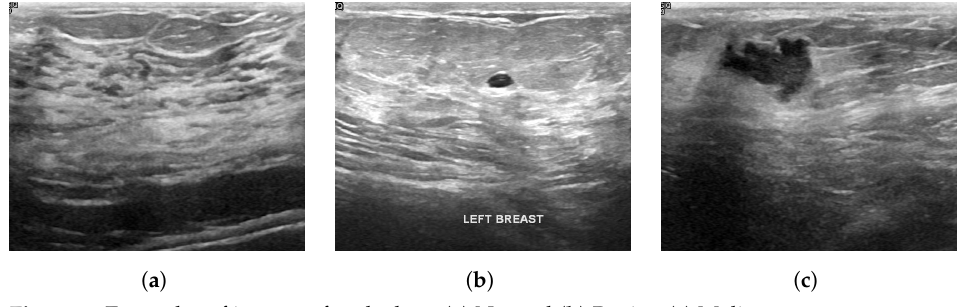
Figure 2. Examples of images of each class. ( a ) Normal ( b ) Benign ( c ) Malignant. Table 1. Base data of the images considered for